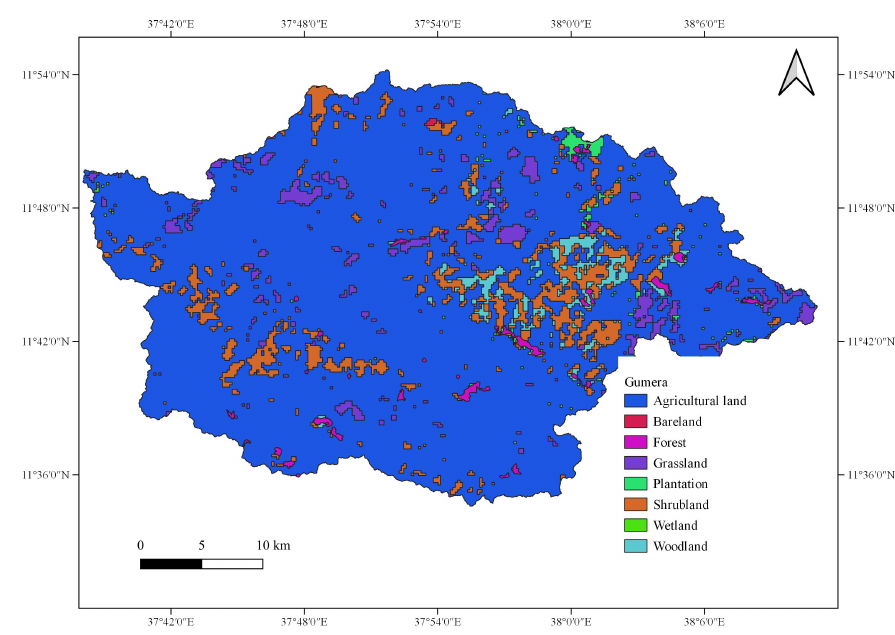
Figure A8. Land use map of Gumera Watershed from 1989 to